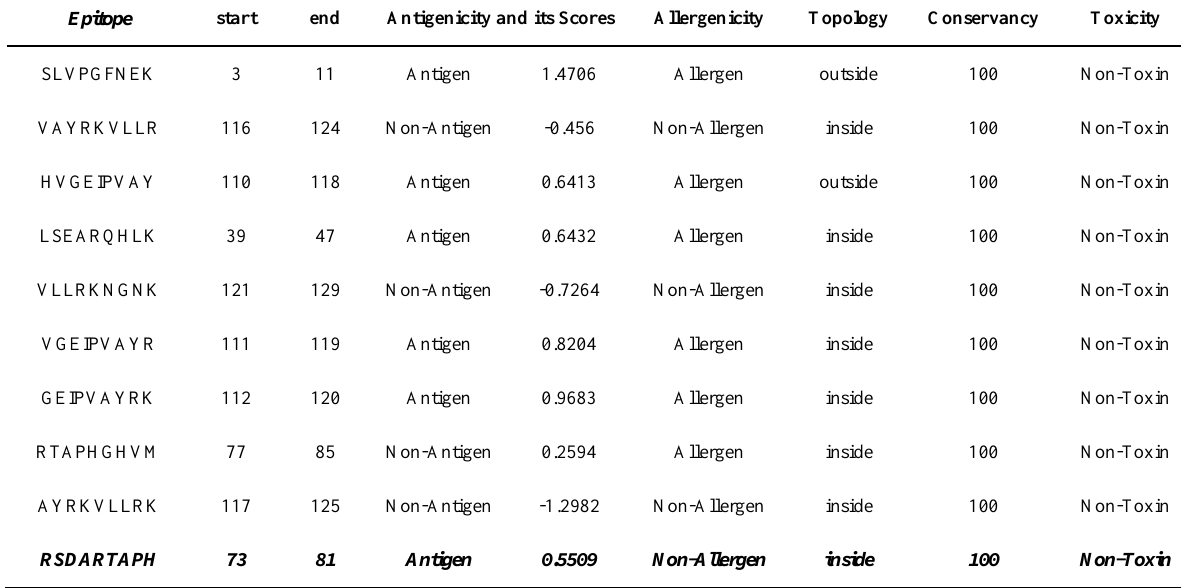
Table 4. List of MHC Class-I epitopes for selected leader protein ORF1ab MT326102 along with their respective antigenicity score, allergenicity, topology, conservancy and toxicity measure. The epitope in bold italics represented the chosen epitope for 3D